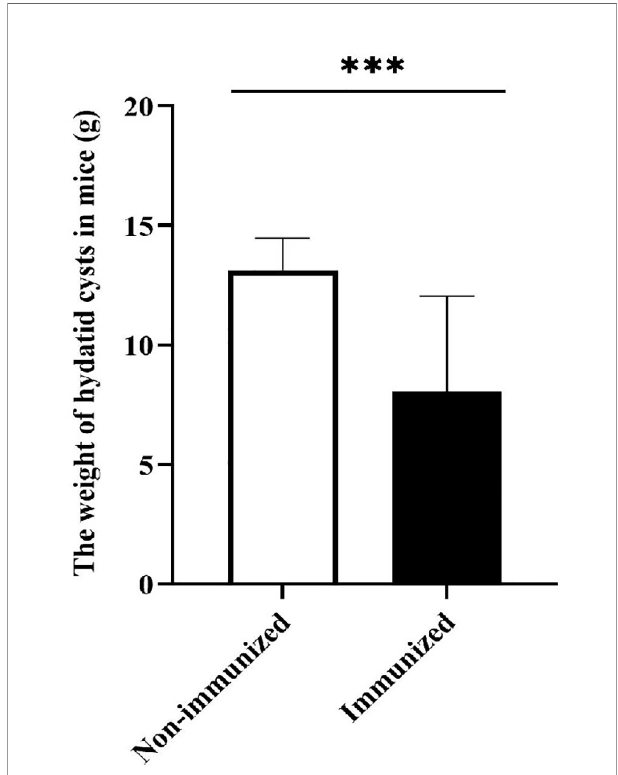
FIGURE 12 | The weight of hydatid cysts. The difference in the weight of hydatid cysts between Immunized group and Non-immunized group was statistically signi fi cant. (*** P <